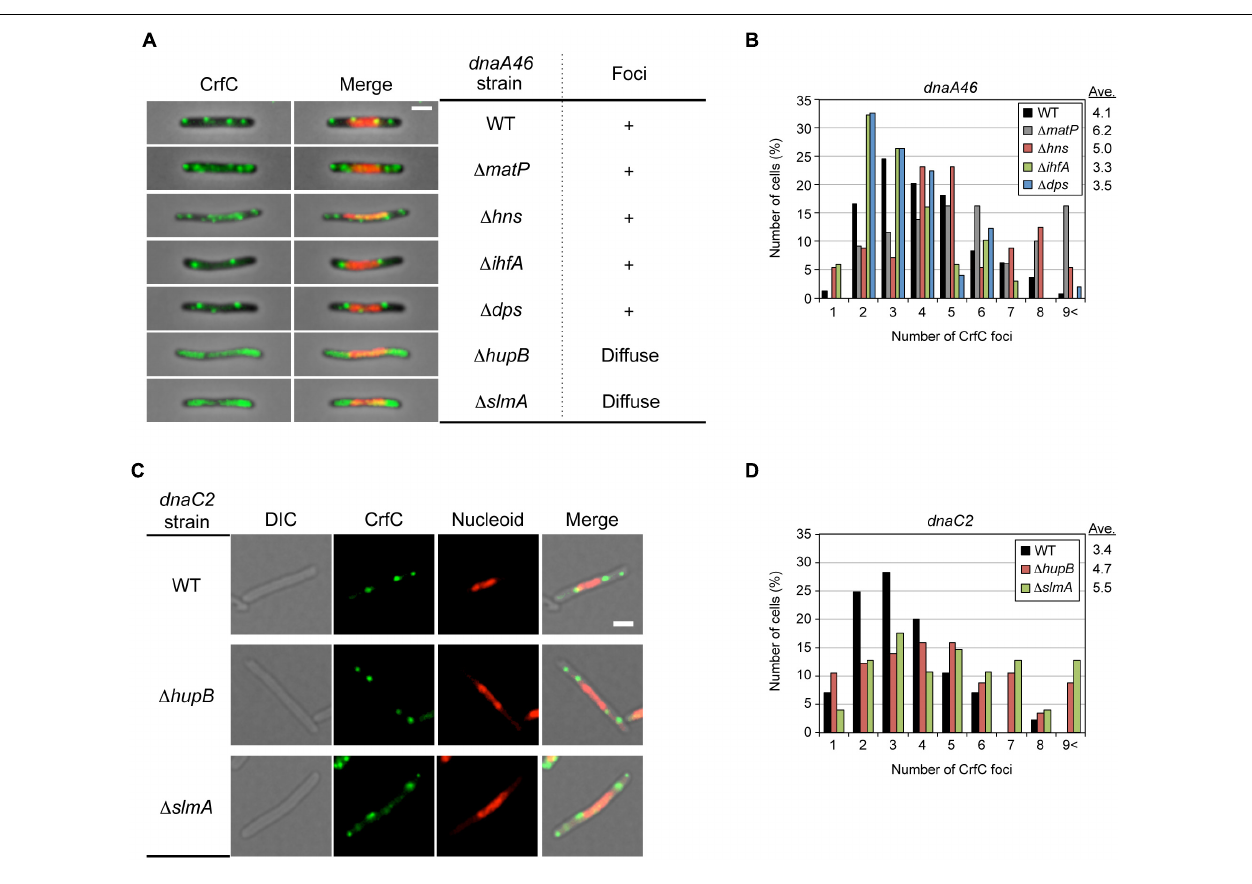
FIGURE 8 | Effect of dnaA46 double mutation on CrfC localization. (A) Subcellular localization of CrfC in MECS135 ( dnaA46 ) cells (WT) and its derivatives bearing (cid:49) matP (MECS160), (cid:49) hns (MECS174), (cid:49) ihfA (MECS175), (cid:49) dps (MECS172), (cid:49) hupB (MECS180), or (cid:49) slmA (MECS178). Cells were incubated at 42 ◦ C for 2 h. Left panels show representative images of fluorescent foci and the morphologies of dnaA46 strains. Scale bar is 2 µ m. Right panels show the subcellular localization patterns of CrfC in dnaA46 strains. In certain strains, discrete CrfC foci were constructed (+). In other strains, discrete CrfC foci were not observed, and fluorescence was uniform throughout the cell (Diffuse). (B) Percentages of cells of MECS135 ( dnaA46 ) (WT) and its derivatives bearing (cid:49) matP (MECS160), (cid:49) dps (MECS172), (cid:49) hns (MECS174), or (cid:49) ihfA (MECS175) containing the indicated numbers of CrfC foci. Ave; average number of CrfC foci. In total, 241 (WT), 129( (cid:49) matP ), 49 ( (cid:49) dps ), 56 ( (cid:49) hns ), and 68 ( (cid:49) ihfA ) cells were analyzed. (C) Representative images of fluorescent foci and the morphology of MECS195 ( dnaC2 ), MECS196 ( dnaC2 (cid:49) hupB ) and MECS197 ( dnaC2 (cid:49) slmA ) filamentous cells. Scale bar is 2 µ m. (D) Percentages of cells of MECS195 ( dnaC2 ) (WT), and its derivatives bearing (cid:49)